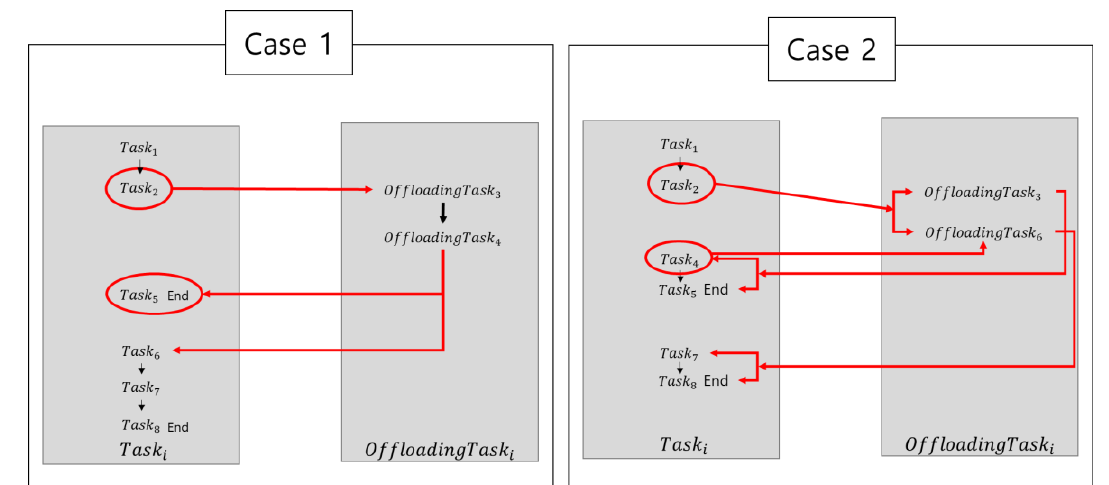
Figure 6. Task connectivity group-based offloading through task mobility.